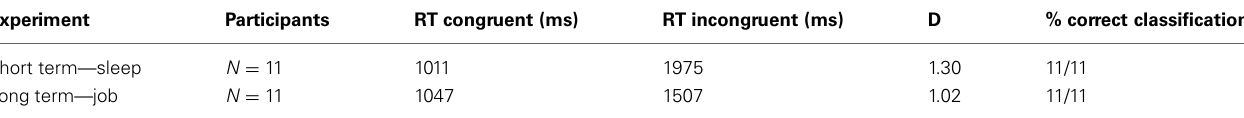
Table 5 | The data for the intention